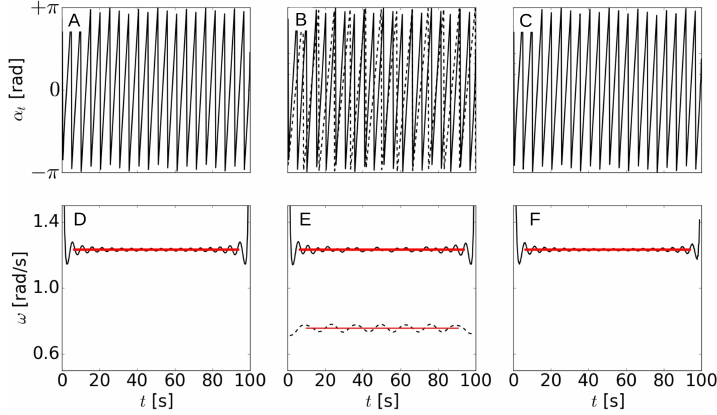
Figure 1. Angle of the Pricipal Component (PC) ( A – C ) and frequency ( D – F ) for the monochromatic ( A , D ), bichromatic ( B , E ), and reflective ( C , F ) 1D cases versus time: First (second) mode is in solid (dashed) lines. Red lines are for the mean angular frequencies.